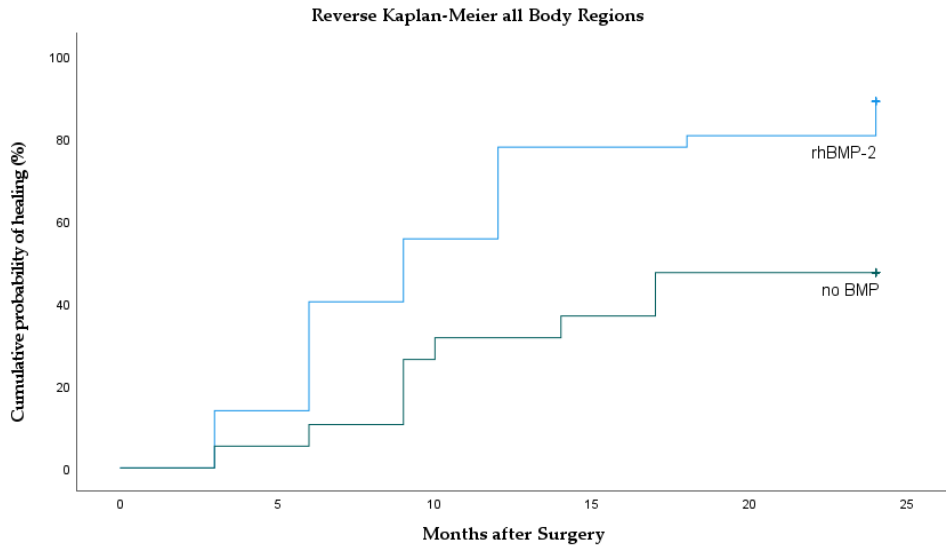
Figure 2. Reverse Kaplan–Meier curves of all body regions showing the incidence of bone healing with and without rhBMP-2 application.